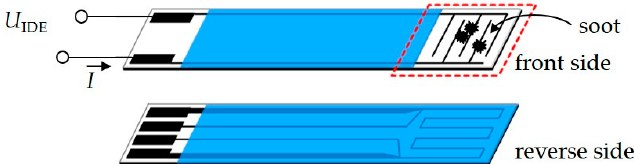
Figure 1. Sketch of the sensor setup: The sensors front side comprises interdigital electrodes (IDE) where soot deposits yield electrical conductive pathways over the spacing. On the reverse side, a four-wire thick-film heater allows temperature-controlled sensor regeneration as well as temperature measurement and temperature adjustment during soot deposition.